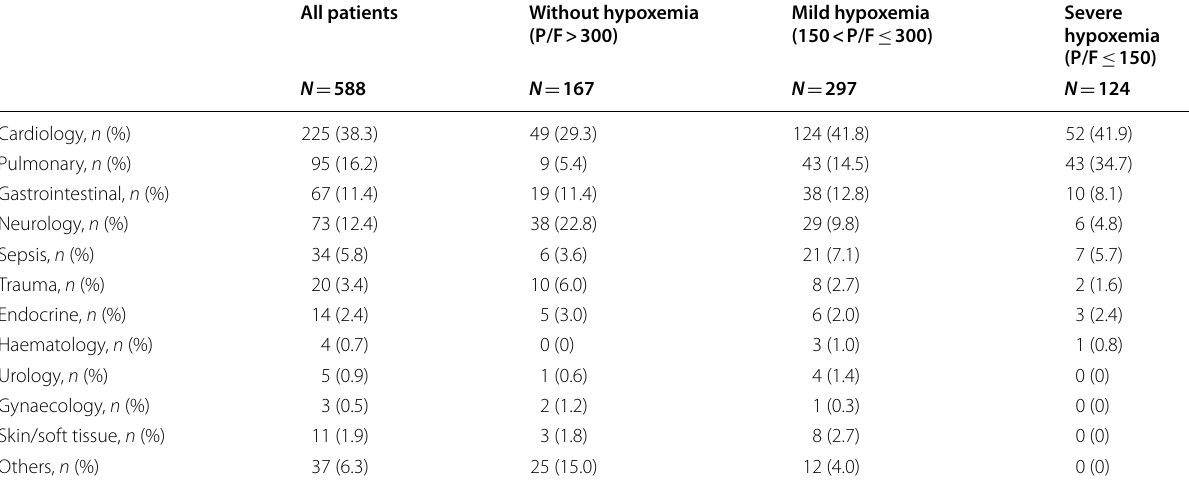
Table 2 ICU admission category